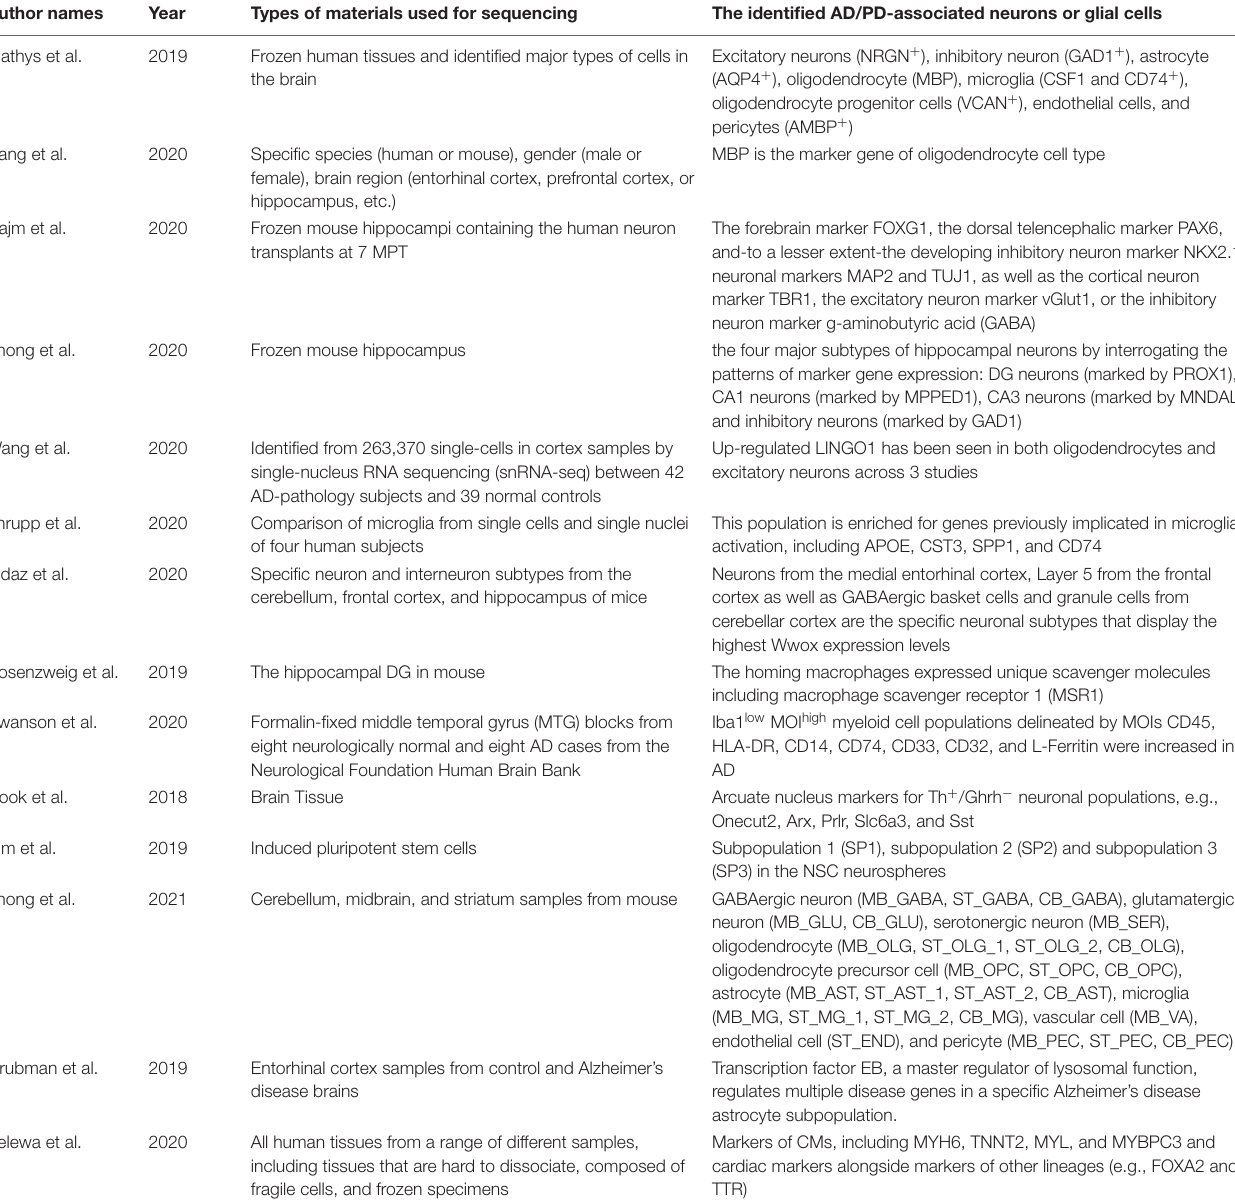
TABLE 1 | Summary of recent studies using RNA-seq in understanding